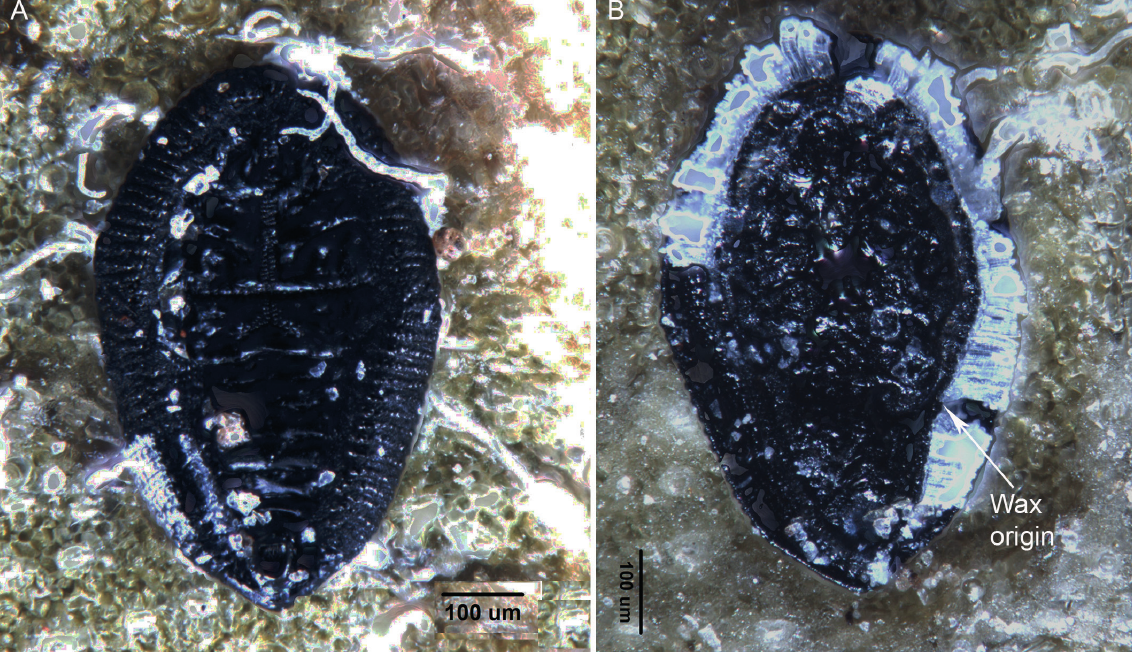
Fig. 7. Aleuropleurocelus ceanothi (Sampson, 1945), habitus. A . Dorsal view. B . Ventral